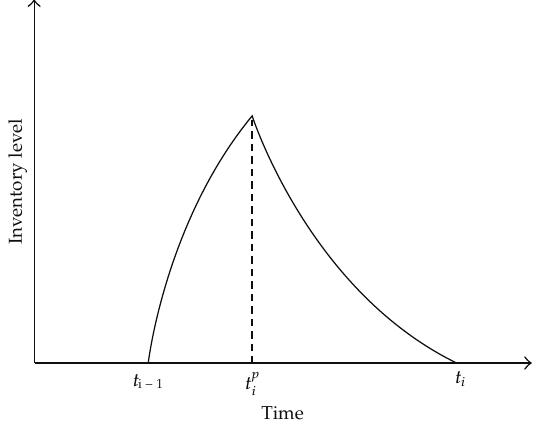
Figure 1: The changes of inventory levels of various components of the model for a typical production